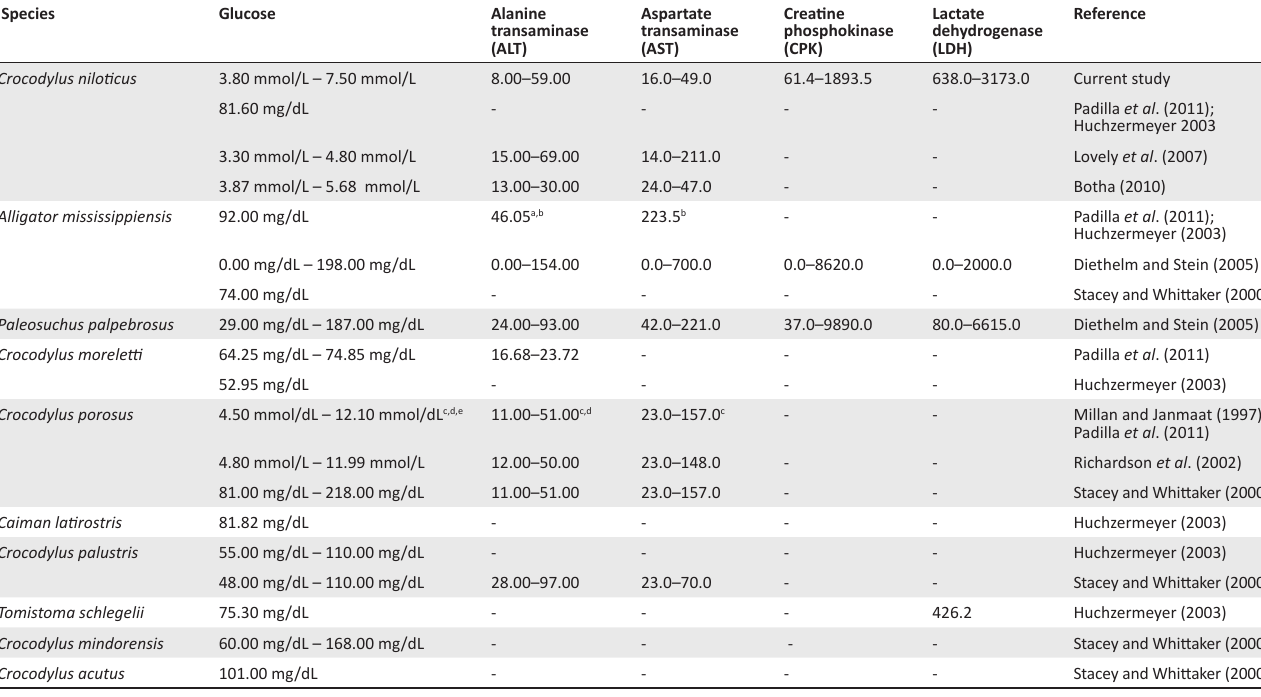
TABLE 1: Biochemical ranges of Crocodylus niloticus and reference ranges reported in other crocodilian species. Species